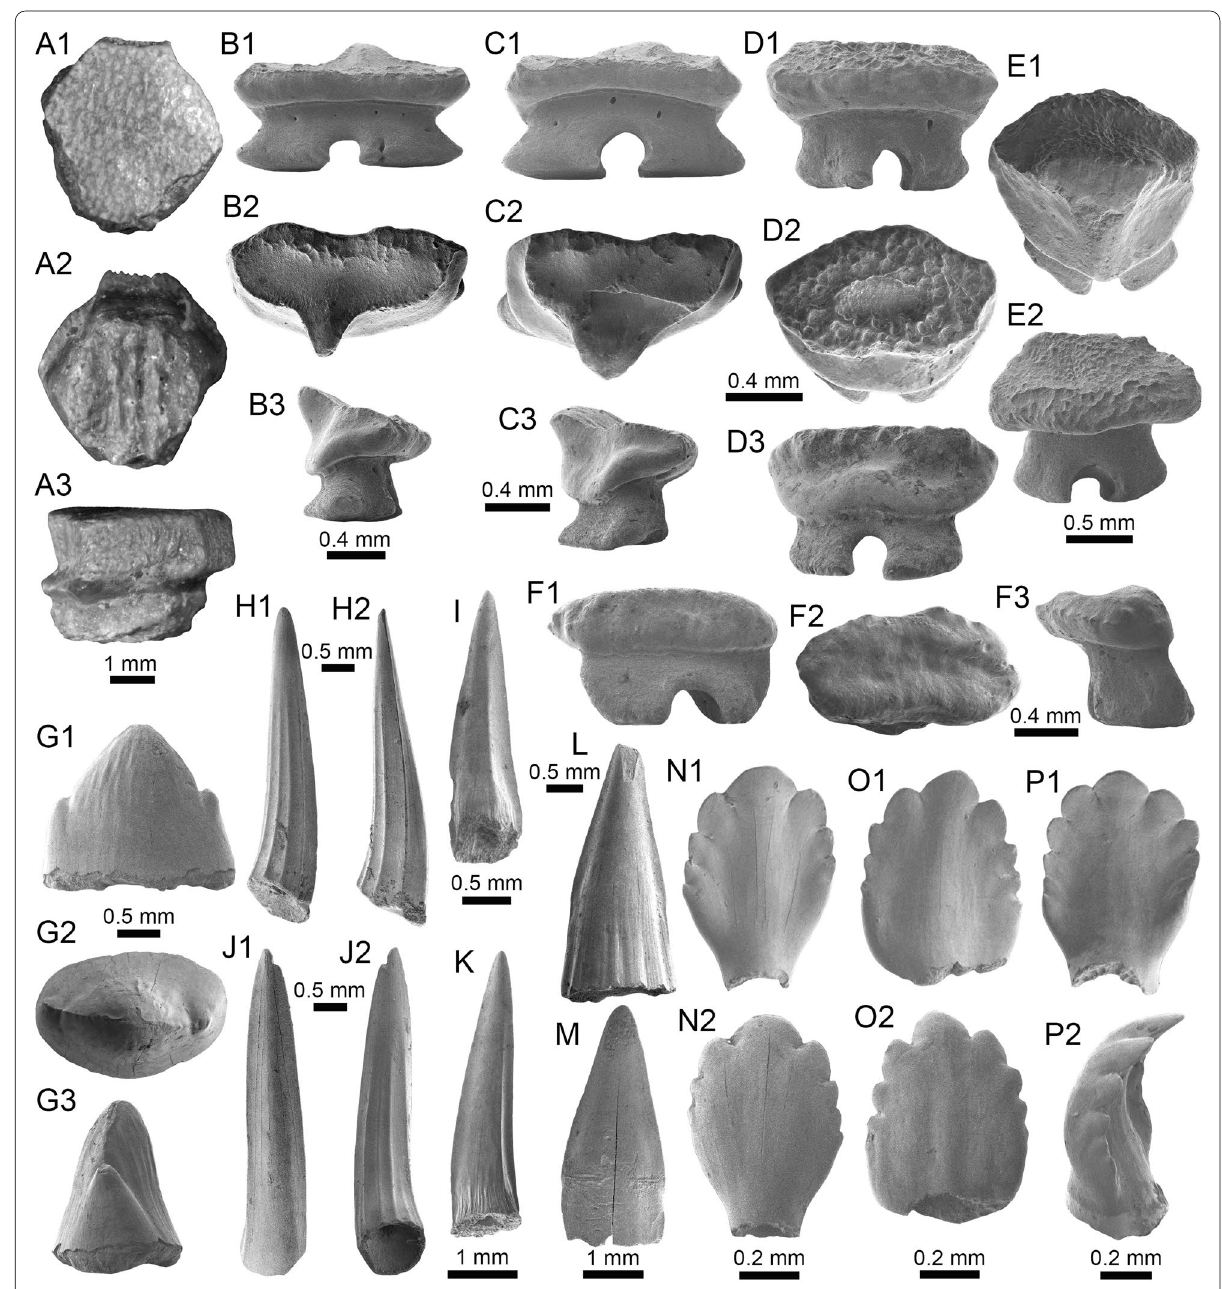
Fig. 3 Rays (Myliobatiformes) and Characiformes fishes from the Iquitos assemblage. A1 – A3 Lateral‑file tooth of Myliobatis or Rhinoptera (PIMUZ A/I 5016). B1 – C3 Potamotrygon aff. † P . rajachloeae teeth (PIMUZ A/I 5052). D1 – E2 . † Potamotrygon canaanorum teeth (PIMUZ A/I 4819). F1 – F3 Potamotrygonidae indet. tooth (PIMUZ A/I 5053). G1–G3 ?Bryconidae or Characidae tooth (PIMUZ A/I 4825). H1 – K Canine ( H1 – H2 , J1 – J2 ) and lateral ( I , K ) Cynodontidae indet. teeth (PIMUZ A/I 4822 and 4823). L – M cf. Hoplias sp. teeth (PIMUZ A/I 4828). N1 – P2 Hemiodus sp. teeth (PIMUZ A/I 4829). Views: labial ( B1 , C1 , D1 , E2 , J1 , M , N2 , O2 ), lingual ( D3 , H1 , J2 , L , N1 , O1 , P1 ), occlusal ( A1 , B2 , C2 , D2 , E1 , G2 ), lateral ( A3 , B3 , C3 , G3 , H2 , I , K , P2 ), basal ( A2 ), and indet. ( G1